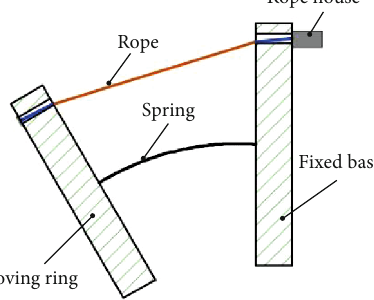
Figure 6: Schematic diagram of the movement without the cable restraint device.